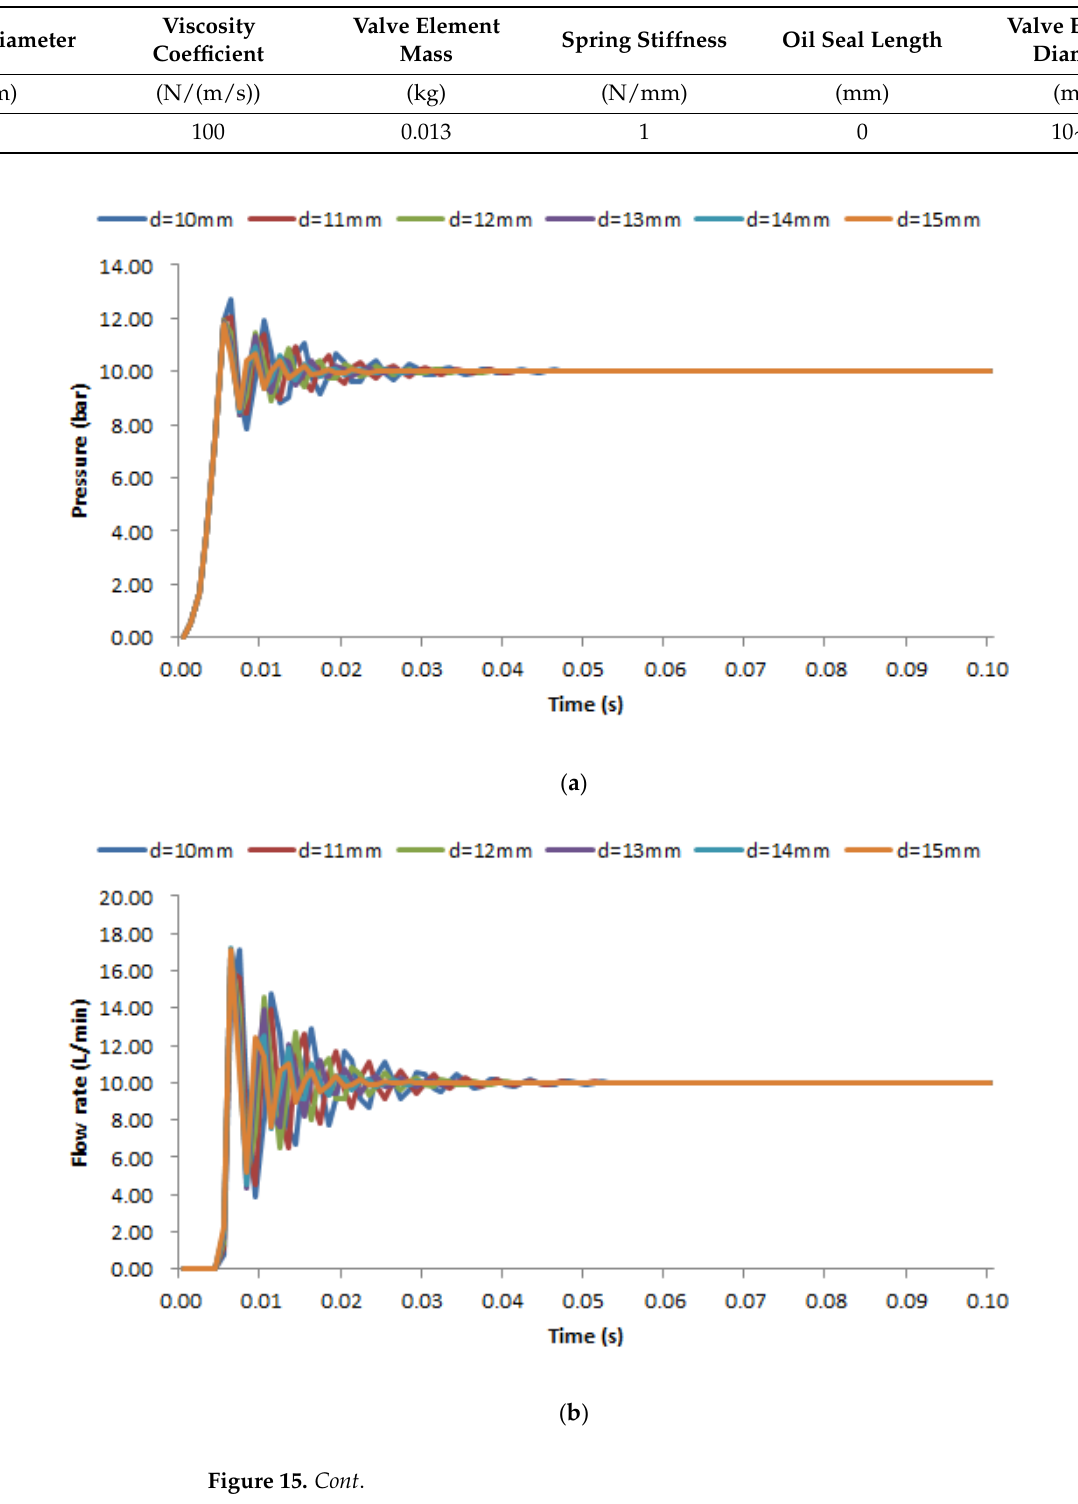
Table 6. Simulation parameters—group 6.